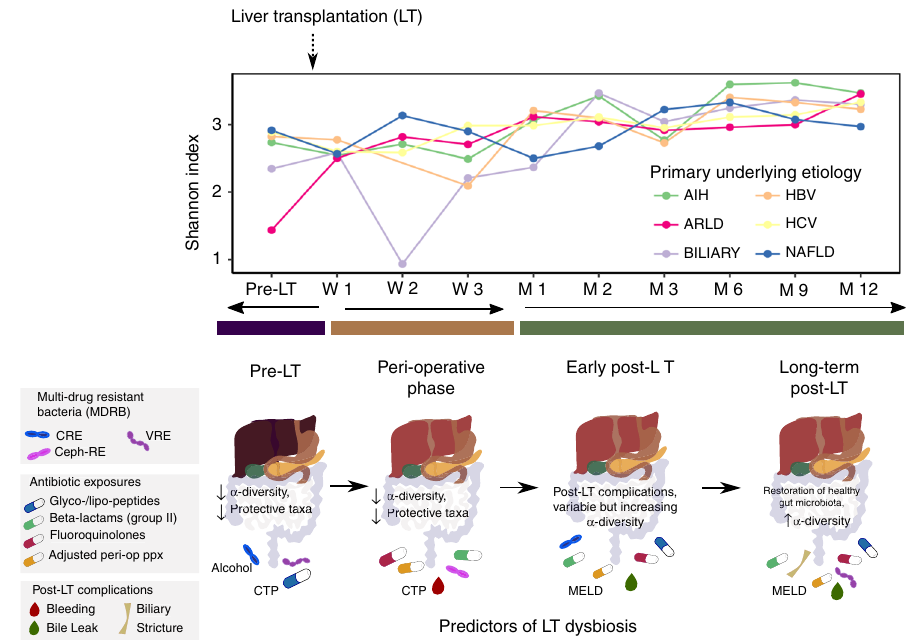
Fig. 4 Microbial and clinical predictors of gut microbiome diversity across pre- and post-transplant phases. (Top) Top panel shows average Shannon α - diversity at each sampling time point within each disease category. (Left) Colonization by CRE or VRE, exposure to glyco-/lipo-proteins (i.e., vancomycin, daptomycin) within 14 days, diagnosis of ARLD, and high CTP score were independent predictors of decreased pre-transplant Shannon α -diversity (multivariate linear regression P < 0.0001). (Center) Peri-LT Shannon α -diversity was signi fi cantly lower given Ceph-RE colonization, exposure to group 2 β -lactams (e.g., piperacillin – tazobactam) or fl uoroquinolones, high CTP score, peri-operative antibiotic regimen adjustments, and post-operative bleeding within 7 days of transplant (multivariate linear mixed-effect regression P < 0.0001). (Right) In the early post-LT period (months 1 – 3), CRE colonization was an independent predictor of Shannon α -diversity after adjusting for exposures to group 2 β -lactams, fl uoroquinolones, and/or glyco-/lipo-proteins, high MELD, peri-operative antibiotic adjustment, and bile leak within 1 year post-LT (multivariate linear mixed-effect regression P < 0.0001). (Right) By the late post-LT phase (months 6 – 12), VRE colonization, group 2 β -lactam exposure, high MELD, peri-operative antibiotic adjustment, and bile leak or biliary stricture within 1 year post -LT were all independent predictors of Shannon α -diversity (multivariate linear mixed-effect regression P < 0.0001). LT